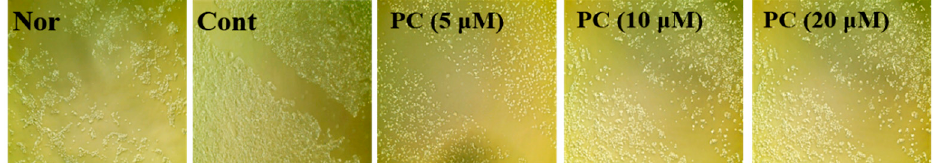
Figure 6. Increased cell proliferation and migration activities of PC (1)-treated HaCaT cells. HaCaT cells were scratched with a yellow tip. Migration levels of HaCaT cells were observed using an optical microscope and photographs were obtained. HaCaT cells were treated with different concentrations of PC (1) (5, 10, 20 µ M) for 24 h. PC (1) treatment led to an increase in the migration of HaCaT cells. Nor: Non-treated cell group (0 h), Cont: 40 mJ/cm 2 UVB-treated cell group.